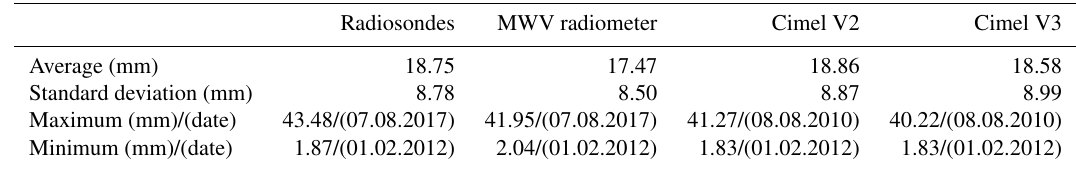
Table 2. Summary of the daily mean statistics of all instruments and algorithms for the period from July 2007 to December